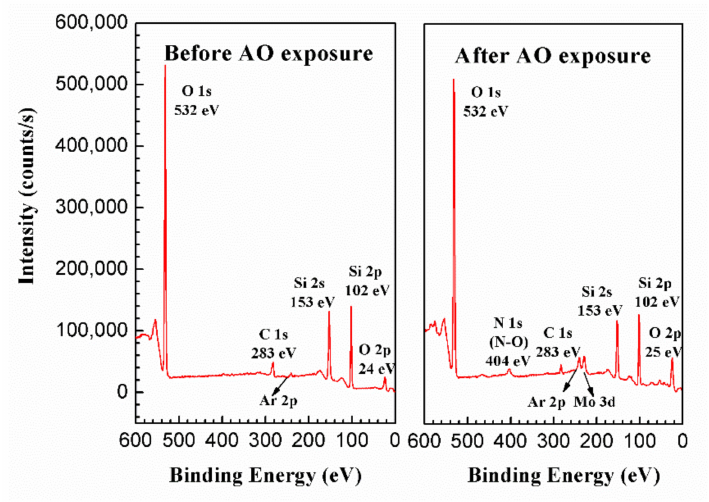
Figure 6. Survey spectra of the etched PHPS coating surface before and after AO exposure.